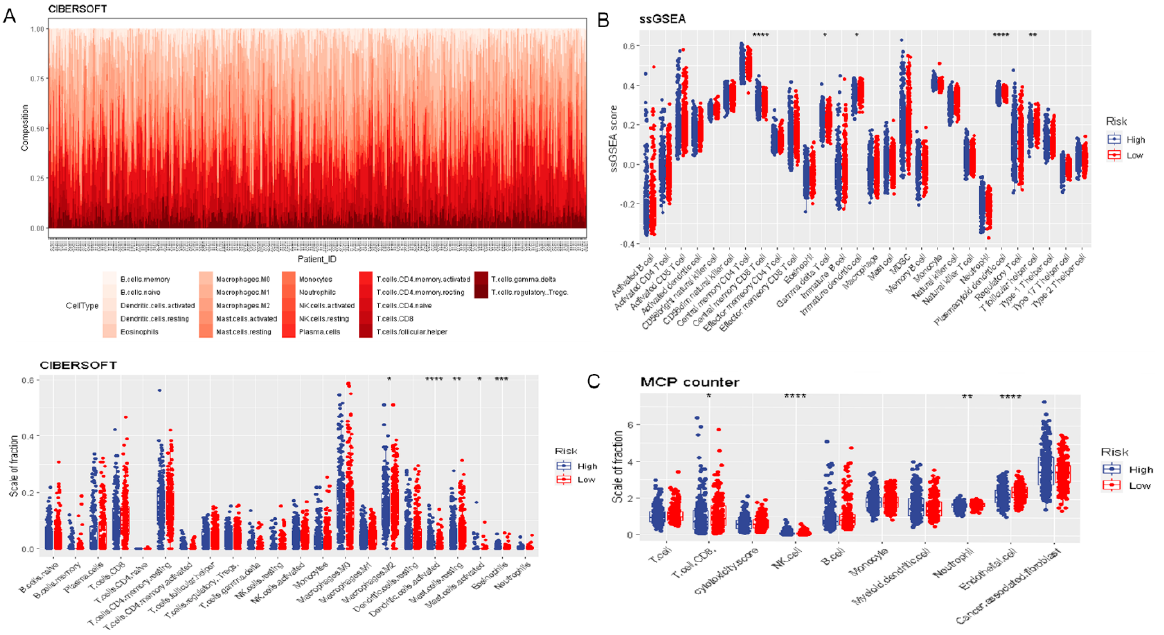
Figure 4. The correlation between risk signature and immune cell infiltration. ( A ) CIBERSORT. ( B ) ssGSEA. ( C ) MCP counter. **** p < 0.0001, *** p < 0.001, ** p < 0.01, and * p < 0.05.